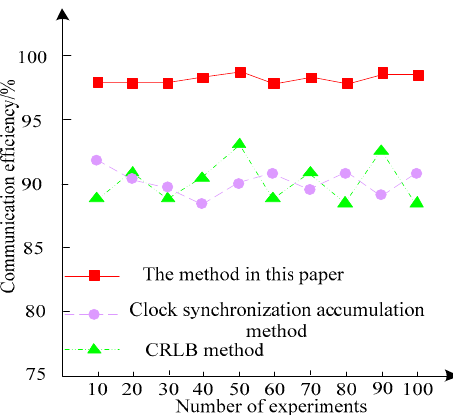
Figure 5. Comparison of communication efficiency between different methods.